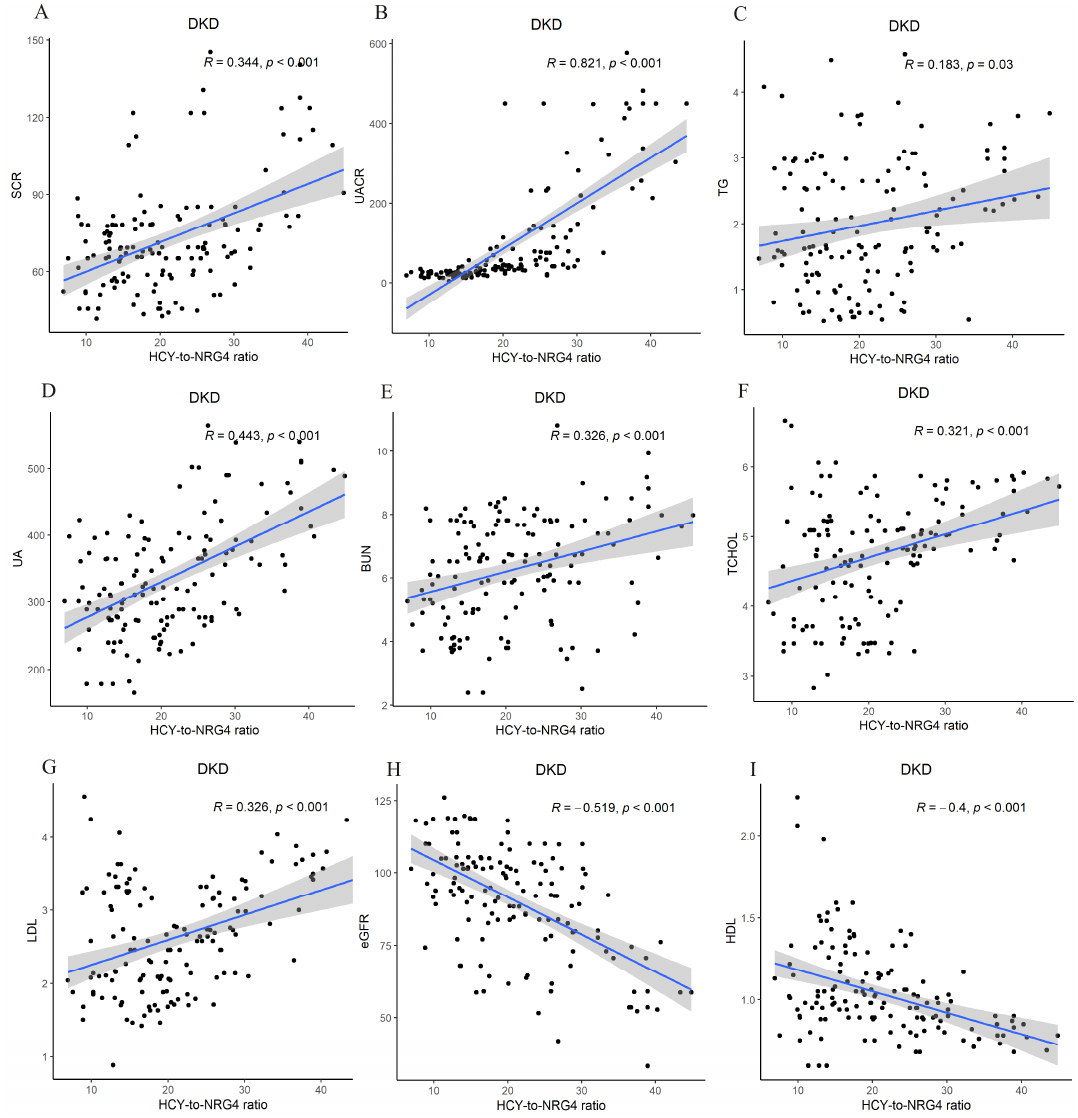
Figure 3. Pearson correlation analysis between serum HCY/NRG4 level and other indicators. Scatter plots showing the correlation between HCY/NRG and SCR, UACR, TG, UA, BUN, TCHOL, LDL, GFR and HDL in patients with DKD. HCY/NRG4 was positively correlated with SCR, UACR, TG, UA, BUN, TCHOL and LDL ( A – G ) but negatively correlated with GFR and HDL ( H , I ).